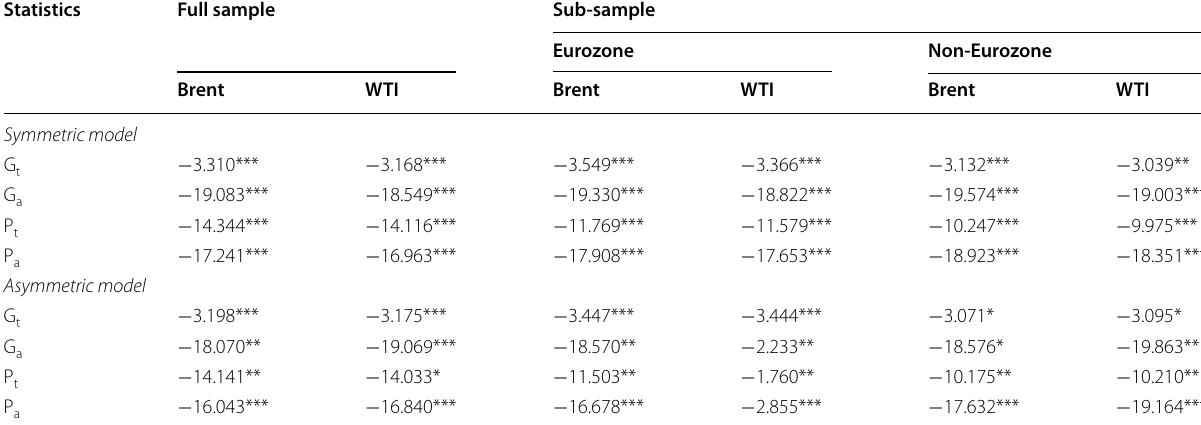
G t and G a denote group mean tests, while P t and P a denote panel mean tests. ***, ** and * indicate significance at 1%, 5% and 10% critical levels, respectively